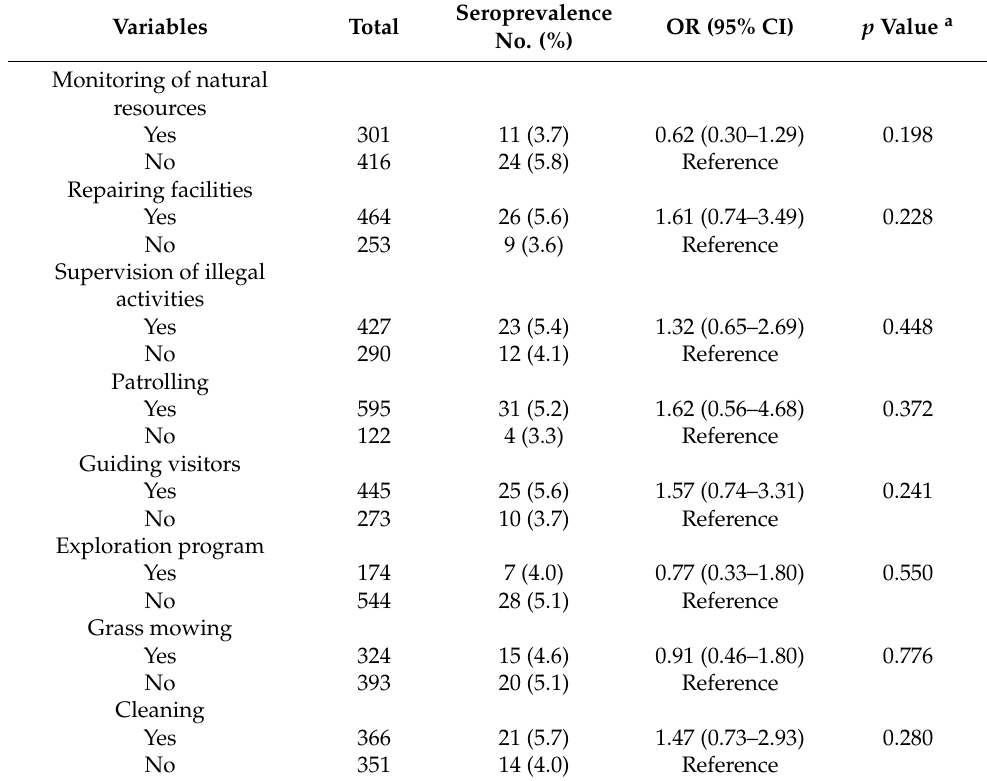
Table 3. Association between work activities and scrub typhus seroprevalence among National Park Office forestry workers in South